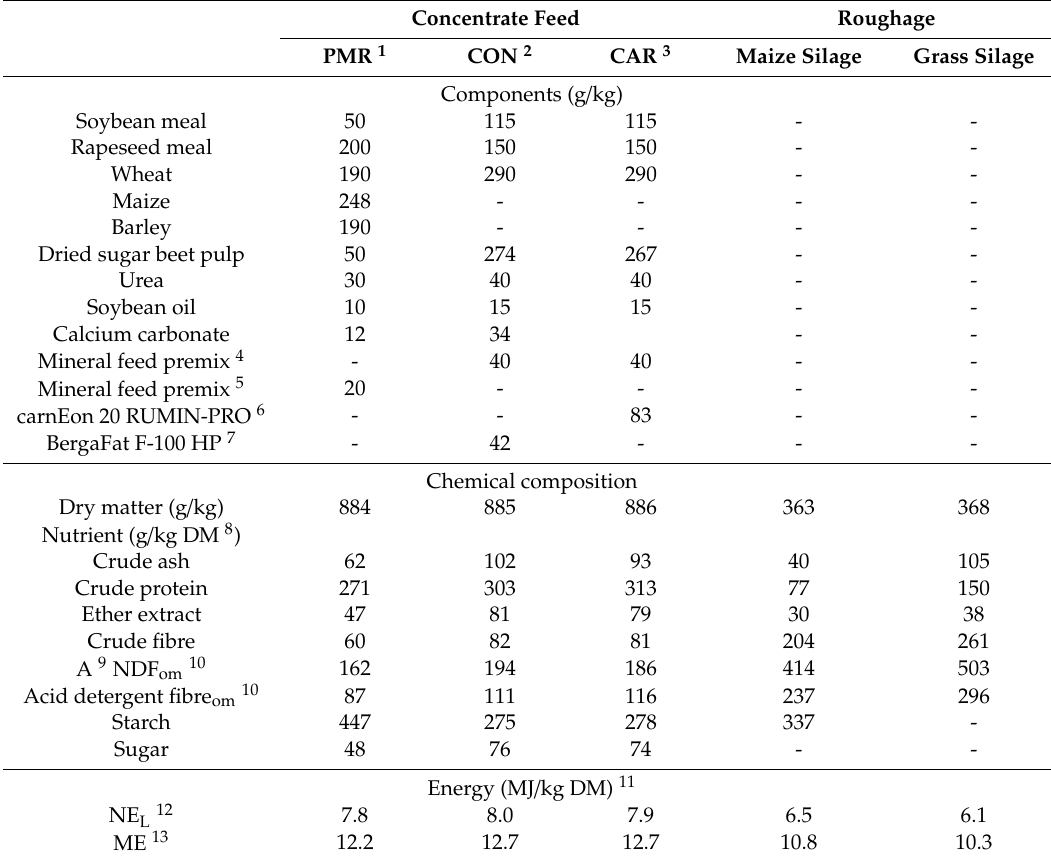
Table 1. Components and chemical compositions of concentrates and roughages in experimental diets. Concentrate